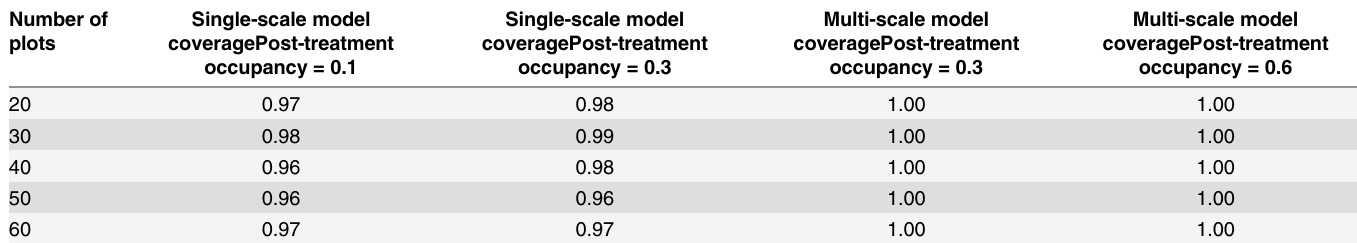
Table 2. Estimated coverage probabilities for nominal 95% equal-tail credible intervals of the treatment effect estimator from hierarchical single- scale and multi-scale occupancy models. Results in this table are limited to combinations with detection probability of 0.3 and seven plots. Results for other conditions are consistent with these trends (S3 and S4